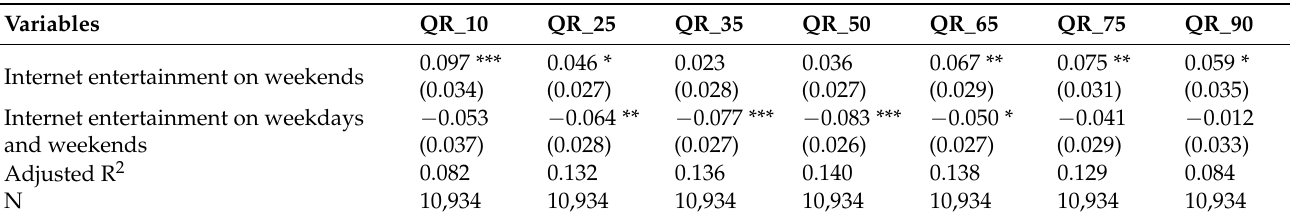
Table 4. Quantile regression